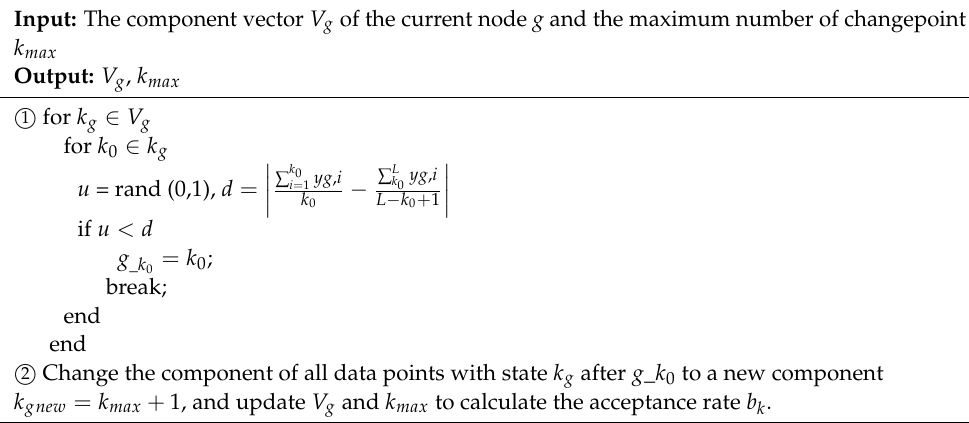
Algorithm 3: Pseudocode for changepoint birth move detection based on the Euclidean distance of data points